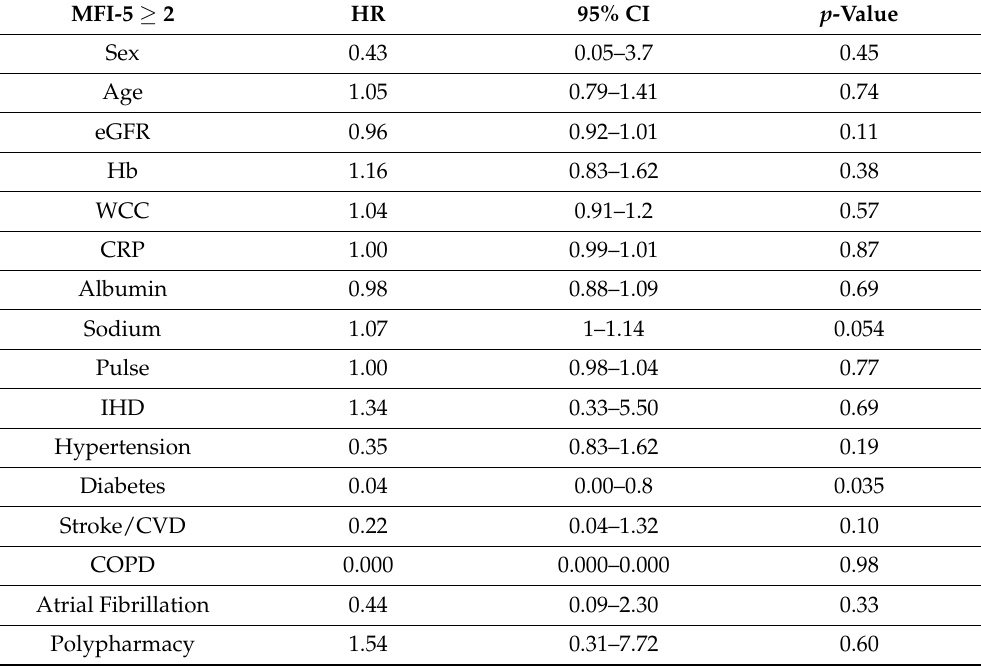
Table 4. Fully adjusted multivariate Cox proportional hazards model for frail patients (MFI-5 ≥ 2). MFI-5 ≥